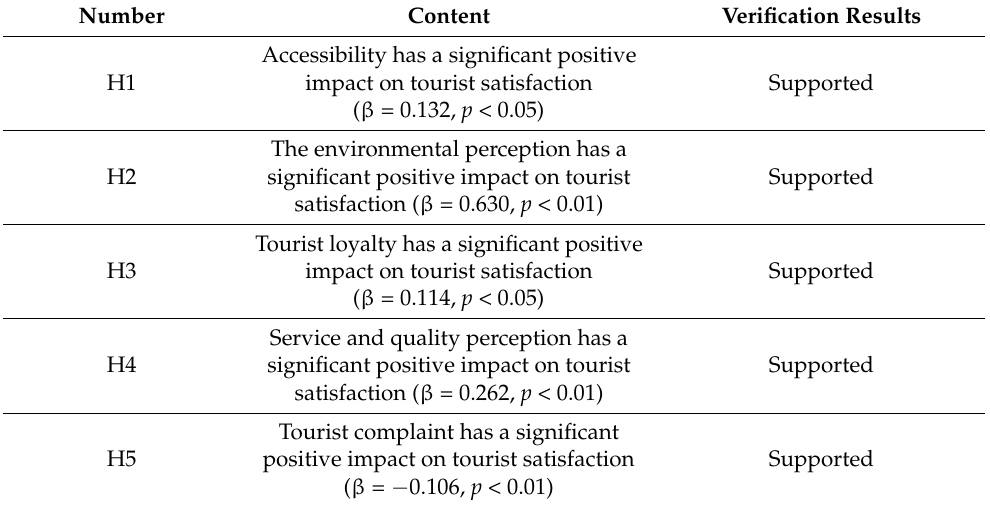
Table 8. Hypothesis test